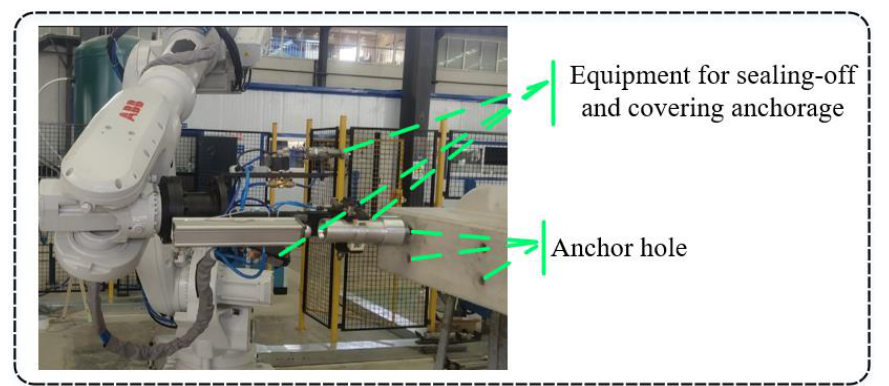
Figure 16. Image processing software interface.